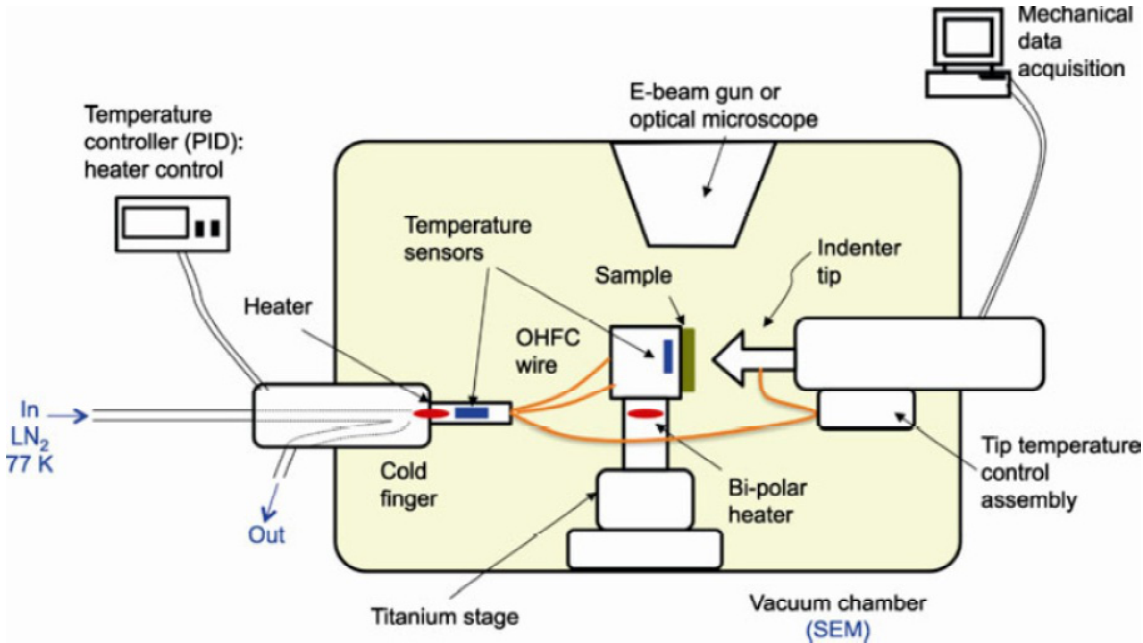
Fig. 2. Schematic diagram of an in-situ nanome-chanical tester integrated with the cryogenic system. Reprinted with permission from Lee SW, Cheng YT, Ryu I, Greer JR. 2014. Cold-temperature deformation of nano-sized tungsten and niobium as revealed by in-situ nano-mechanical experiments, Science China- Technological Sciences 57: (c) 2014 Springer